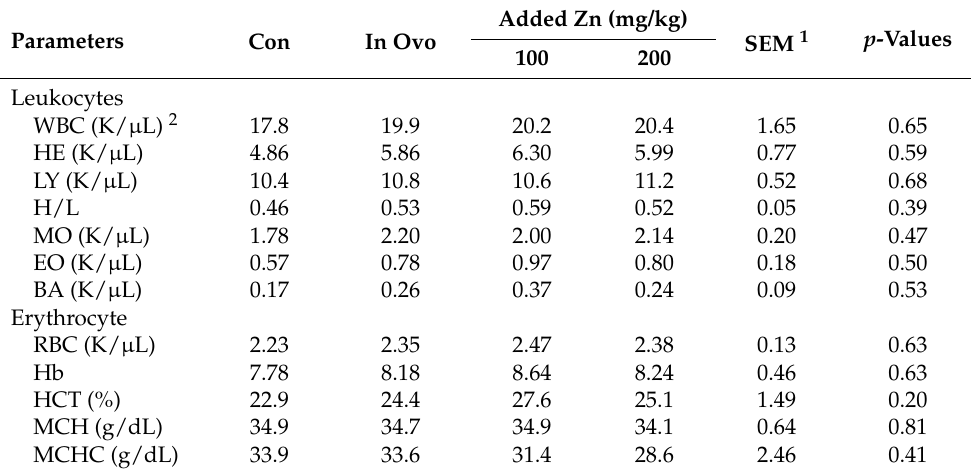
Table 4. Effect of in ovo injected and supplemental Zn on leukocytes and erythrocytes in broilers at 35 days of age.